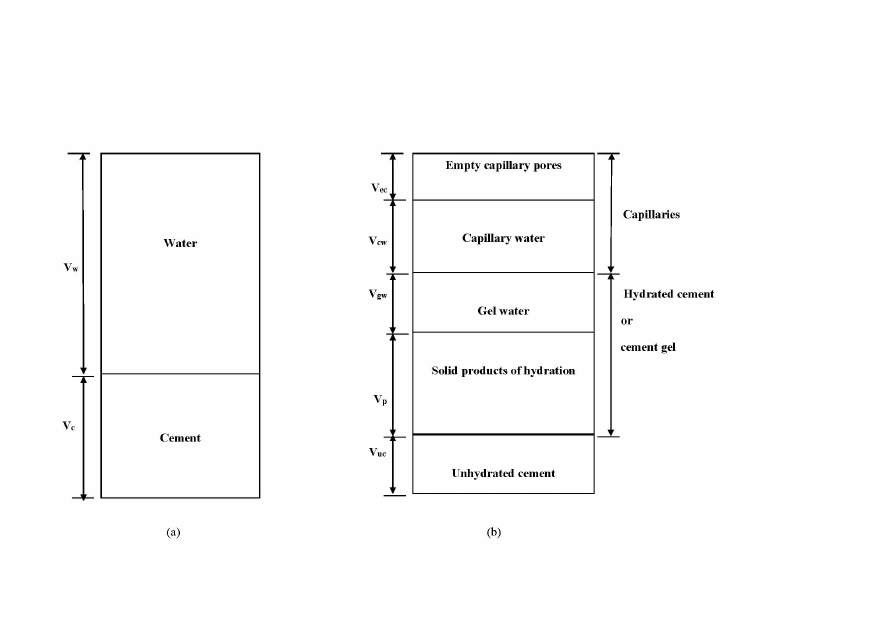
Fig. 1. Volumetric proportions: (a) prior to hydration (degree of hydration, h = 0), and (b) while hydration occurs (degree of hydration, h)